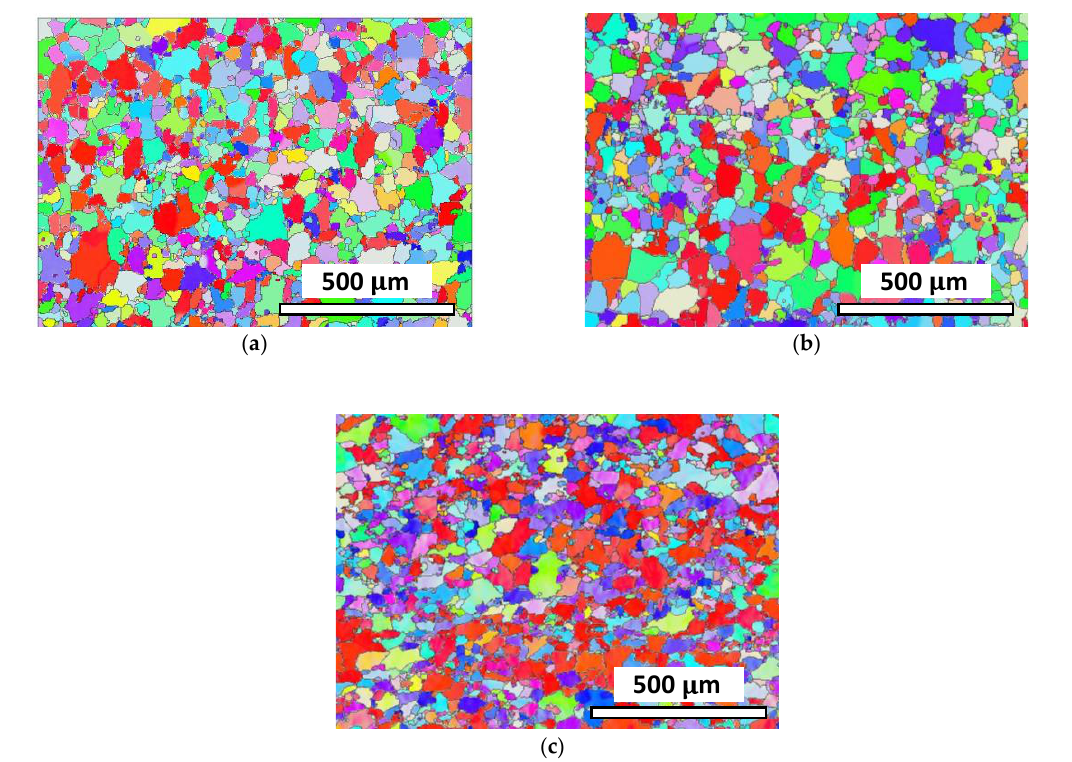
Figure 4. EBSD observations of ( a ) the as-received T6 sample, ( b ) the sample heated to 400 ◦ C and ( c ) post hot tensile to a total strain of 0.3 at 400 ◦ C.